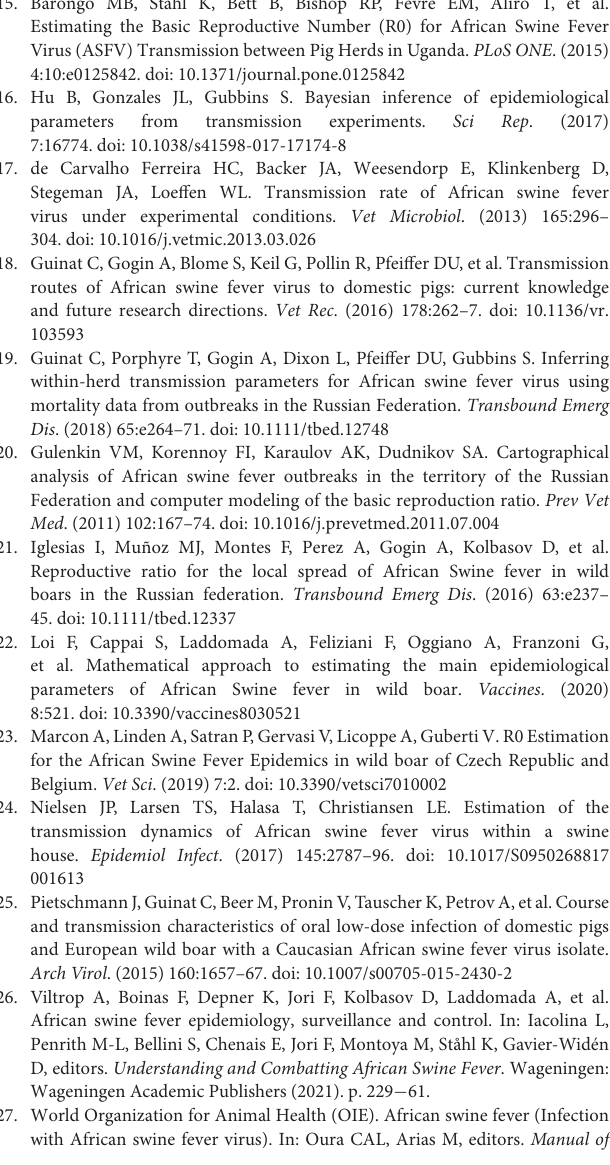
population density is expressed as a log. The colored envelopes represent the 95% confidence intervals. Supplementary Table 1 | List of the variable collected by the Epidemiological Investigation